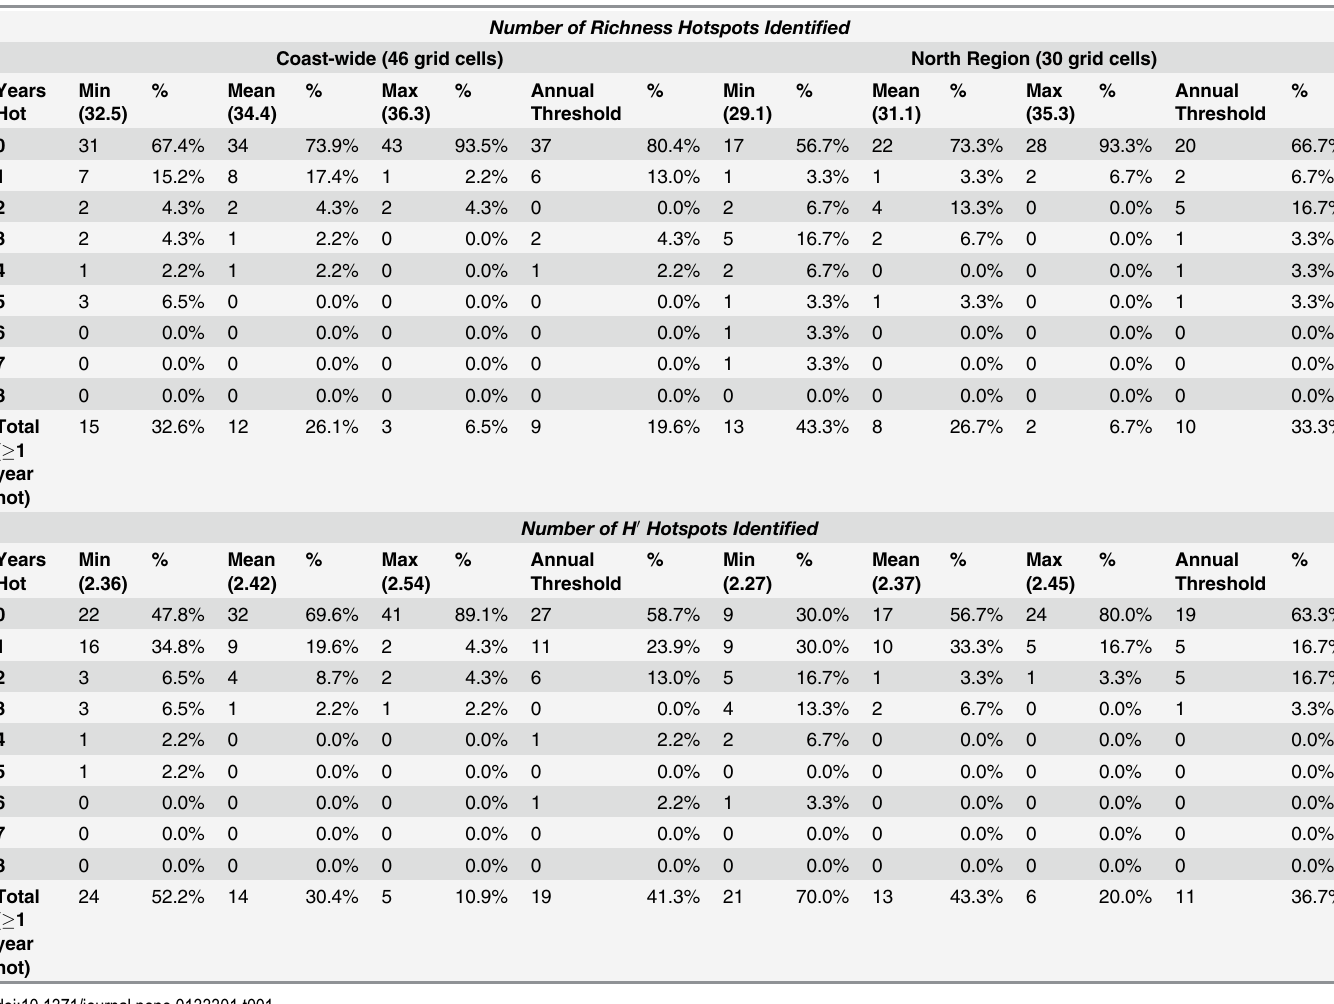
Table 1. Number of grid cells (and percentage of total) designated as benthic fish biodiversity hotspots (temporal consistency ranging from 0 years hot to 8 years hot) for Coast-wide and the North biogeographic regions and for the minimum, mean, and maximum universal thresholds and annual threshold calculated for 2003 –